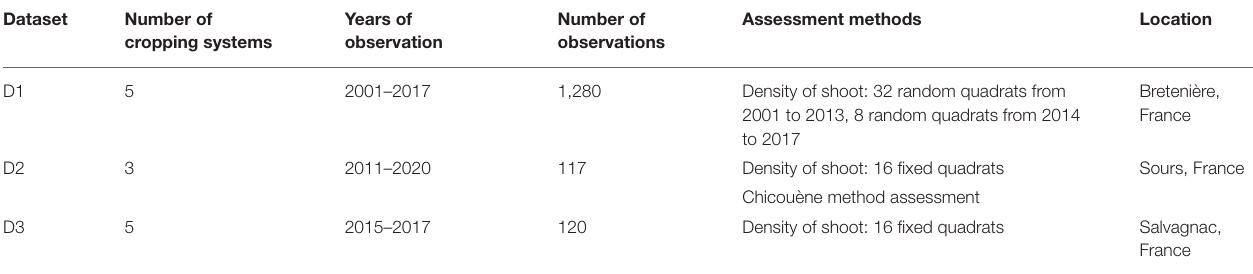
TABLE 2 | Summary of the datasets used in the evaluation of the predictive quality.